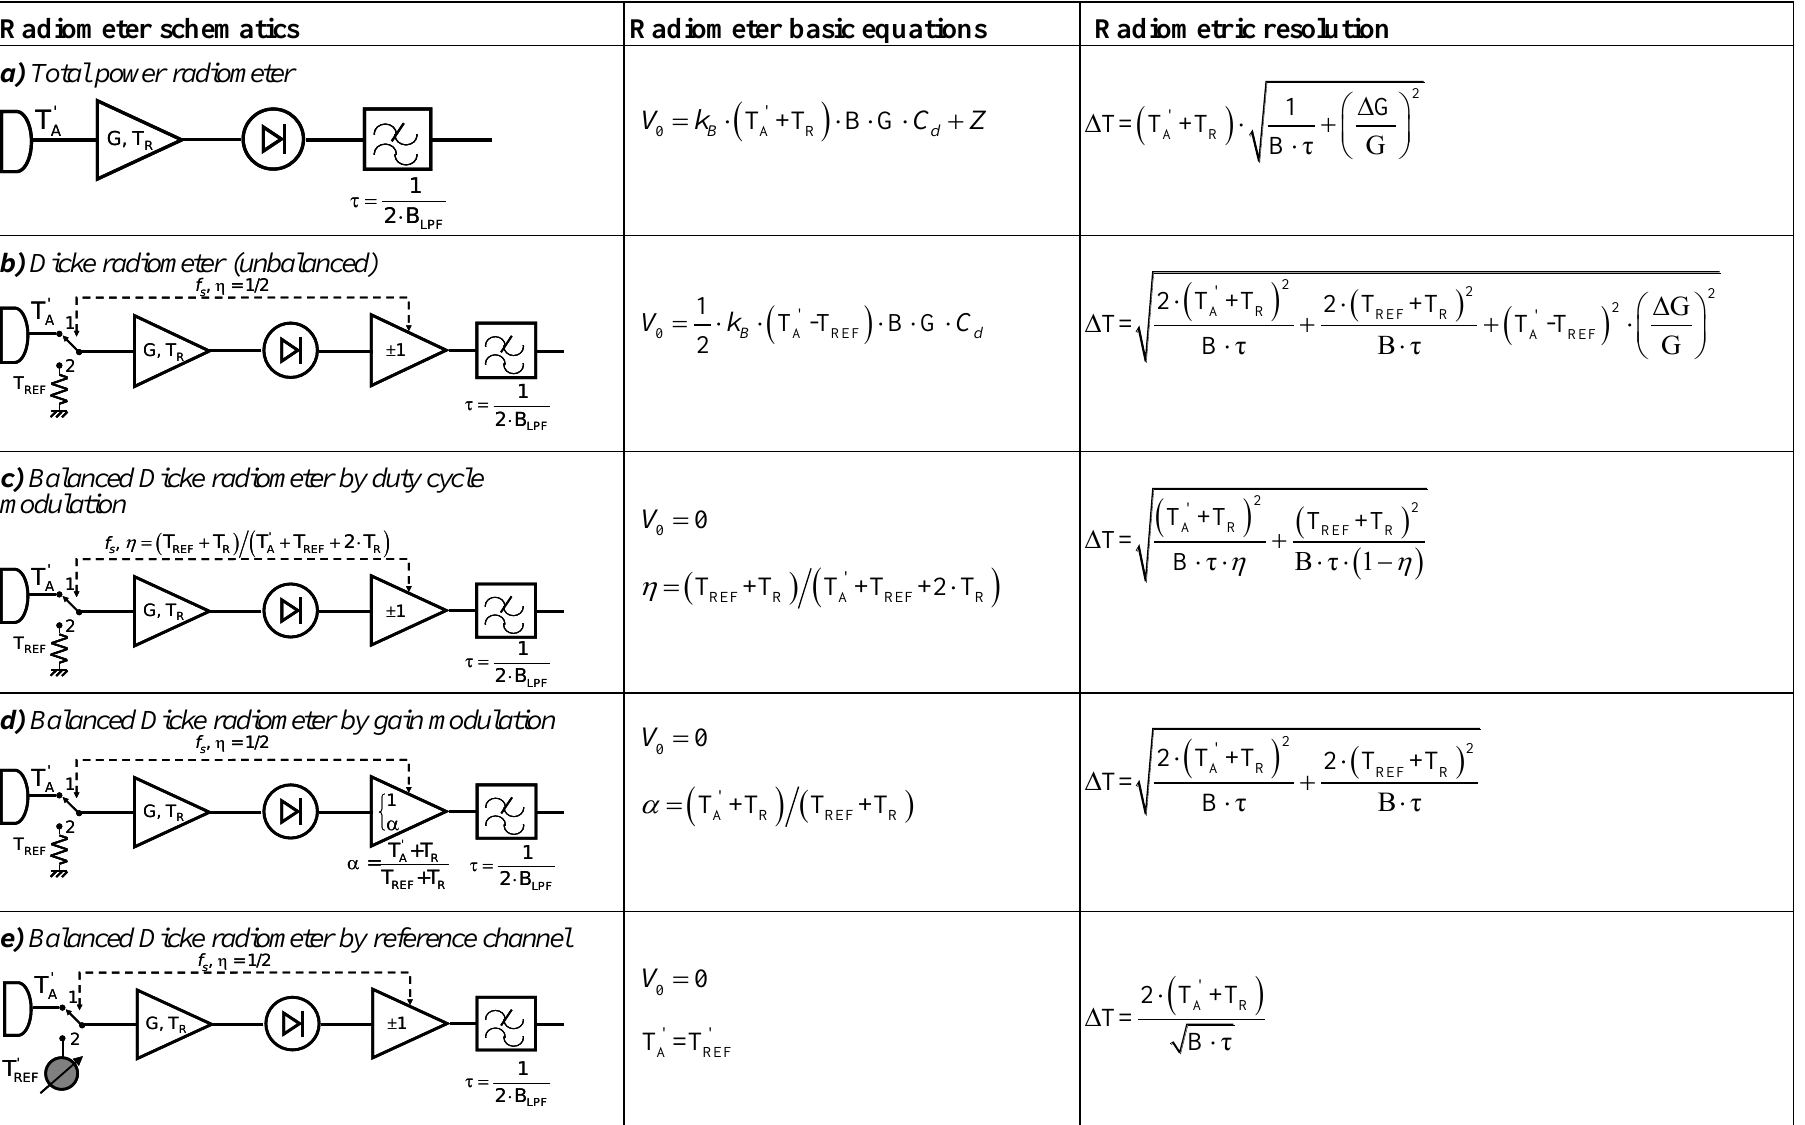
Table 1. Main types of radiometers: block diagram, basic equations and radiometric